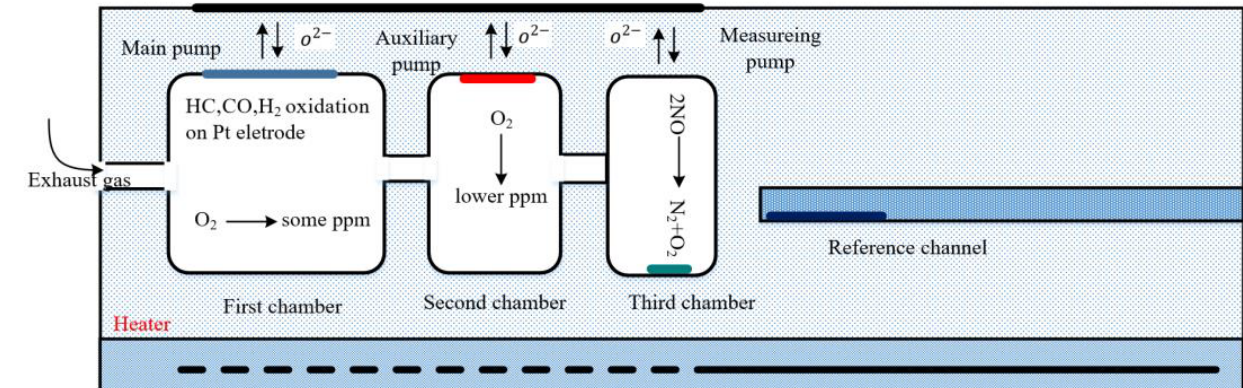
Figure 1. The diagram of NOx sensor working process.